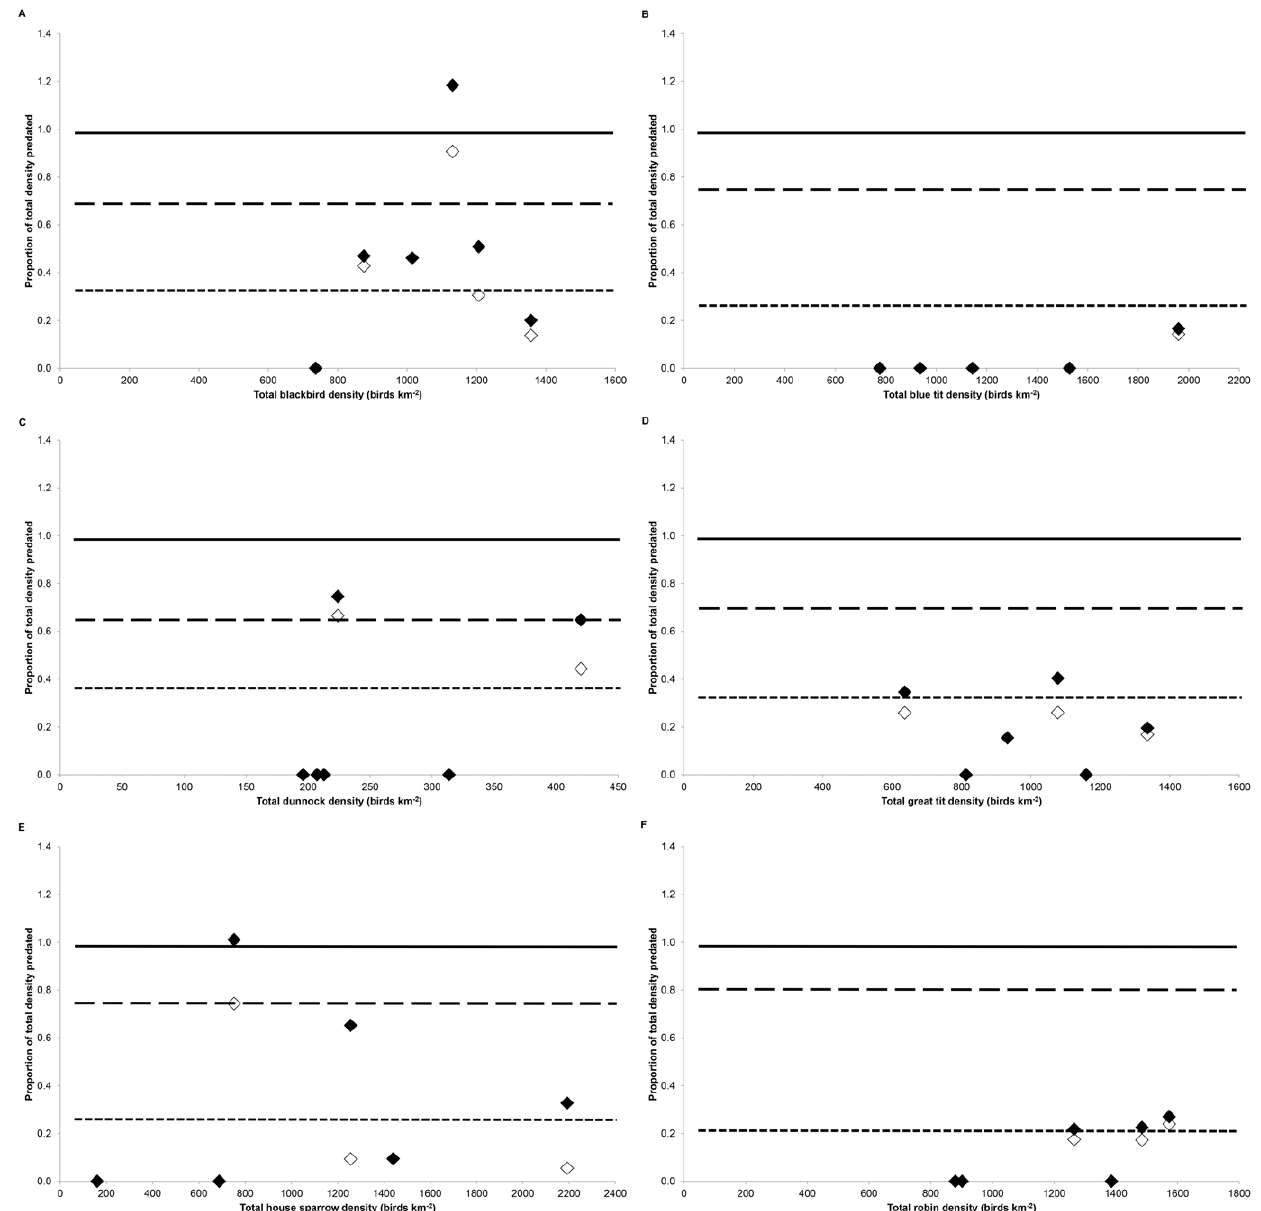
Figure 6. Relationship between the density of (a) blackbirds, (b) blue tits, (c) dunnocks, (d) great tits, (e) house sparrows and (f) robins and the estimated proportion of the population killed (N=6 squares). The solid line denotes the total population (proportion=1): the lower and upper dashed lines indicate the proportion of adults and juveniles in the population respectively. Open and closed symbols denote the estimated minimum and maximum number killed expressed as a proportion of the population.